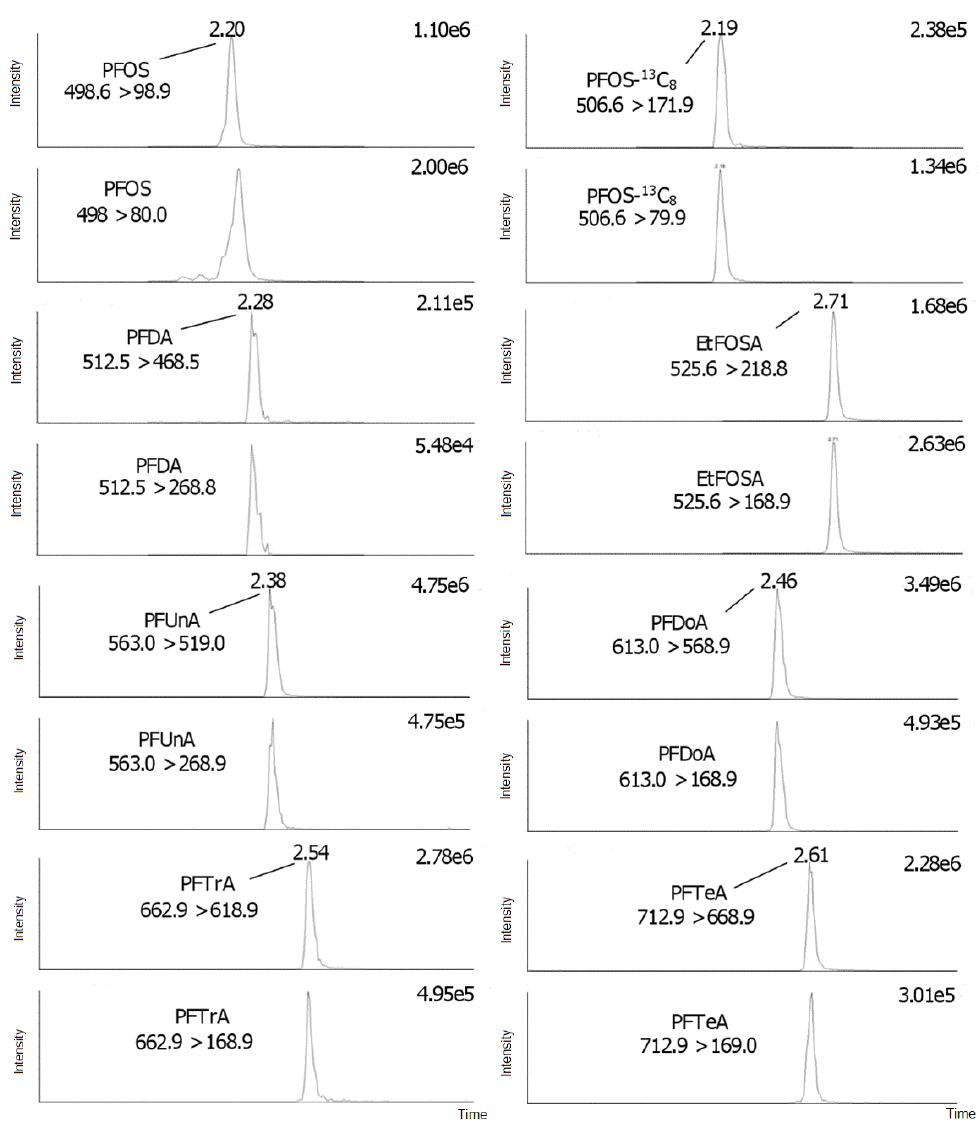
Figure 6. SRM ion chromatograms of PFOS, PFOS- 13 C 8 , PFDA, EtFOSA, PFUnA, PFDoA, PFTrA, and PFTeA.